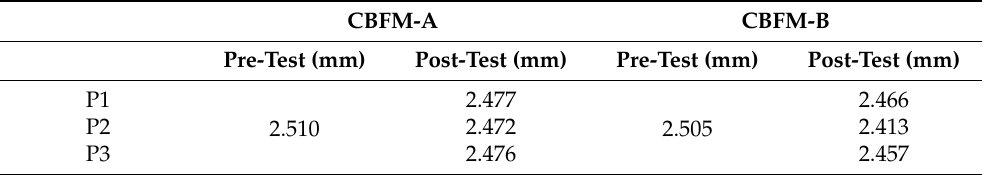
Table 2. Mean thicknesses of discs in CBFM-A and CBFM-B.